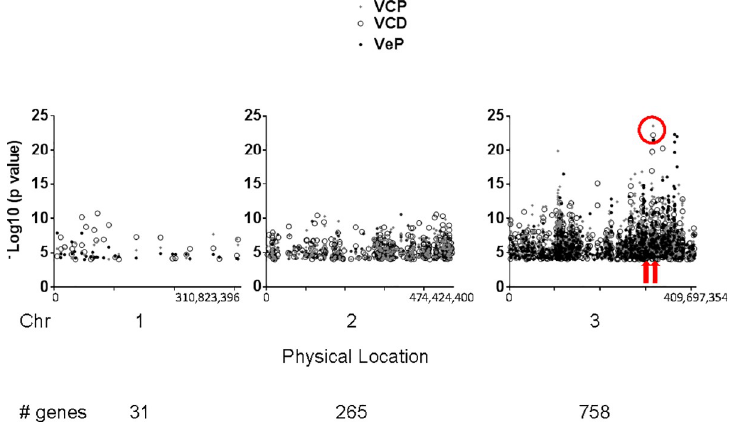
Fig 3. Physical positions of genes in high association subset (n = 1054). Genes were plotted according to their physical positions (AaegL5 reference). Y axis indicates weighted gene-wise average–log 10 ( p value) of χ 2 contingency table calculations. Red circle indicates approximate chromosomal location of the permethrin target site VGSC (nt positions 315,926,360–316,405,639) in VCP, VCD and VeP; red arrows show approximate location of NVY (nt 301,564,432–301,941,839) and CHL (nt 312,986,638–313,140,457). https://doi.org/10.1371/journal.pone.0211497.g003 induced gene silencing via dsRNA-injection to temporarily silence each gene in Vergel colony mosquitoes (F ). Silencing was confirmed relative to levels in non-specific dsRNA ( β -Gal- 24 dsRNA) treated controls (Fig 4A), and mosquitoes were subjected to a 1.5 μ g permethrin dis- criminating dose in standard CDC bottle assays [45]. Both nvy -dsRNA and chl -dsRNA